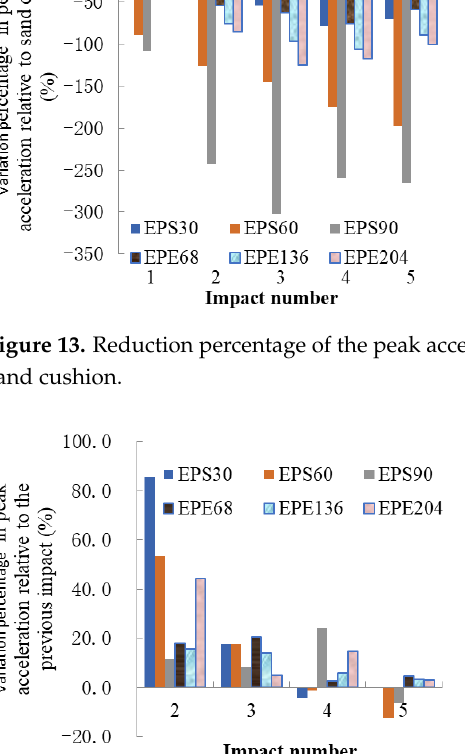
Figure 14. Percentage variation in peak acceleration relative to the previous impact.